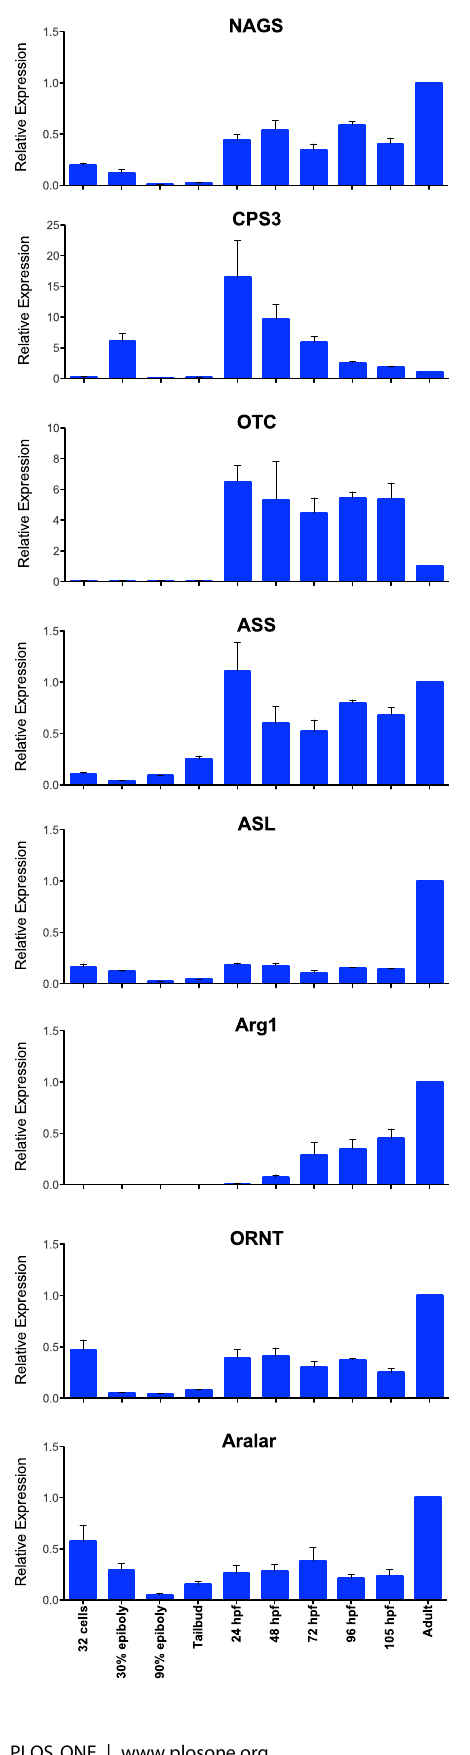
Figure 1. Relative expression of urea cycle genes in developing zebrafish. mRNA levels were measured at nine developmental stages: 32 cells, 30% epiboly (4.6 hpf), 90% epiboly (9 hpf), tailbud (10 hpf), 24 hpf, 48 hpf, 72 hpf, 96 hpf, 105 hpf, and normalized to the abundance of each mRNA in adult zebrafish. The scales of y-axes differ due to different expression patterns of zebrafish urea cycle